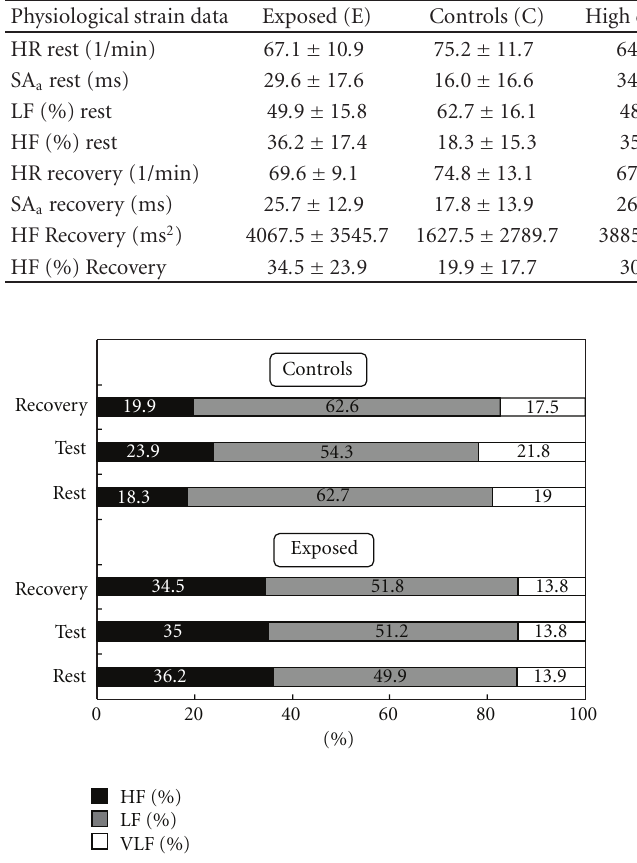
Figure 3: Relative frequency band percentages of cardiac phase duration variability after Fast Fourier Transform for lead-exposed subjects and controls at the stages of rest, “memory span for numbers” test, and